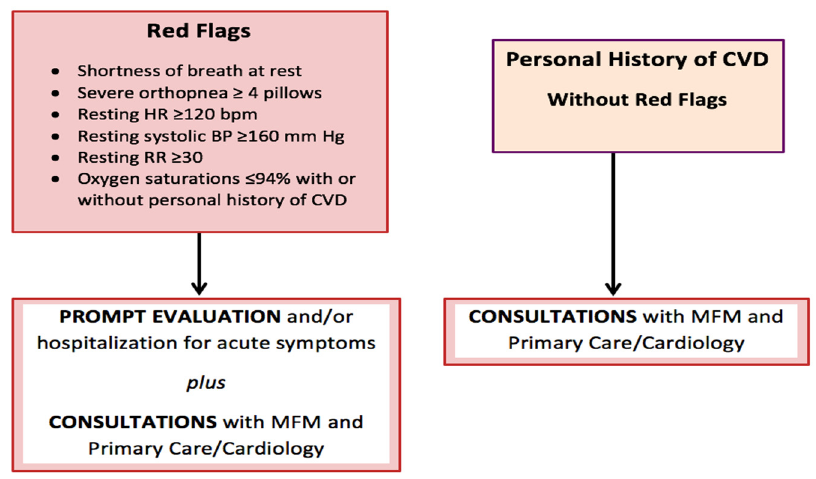
Figure 3. California Maternal Quality Care Collaborative (CMQCC) algorithm to identify red flags in pregnant and postpartum patients that would prompt further cardiovascular disease evaluation.